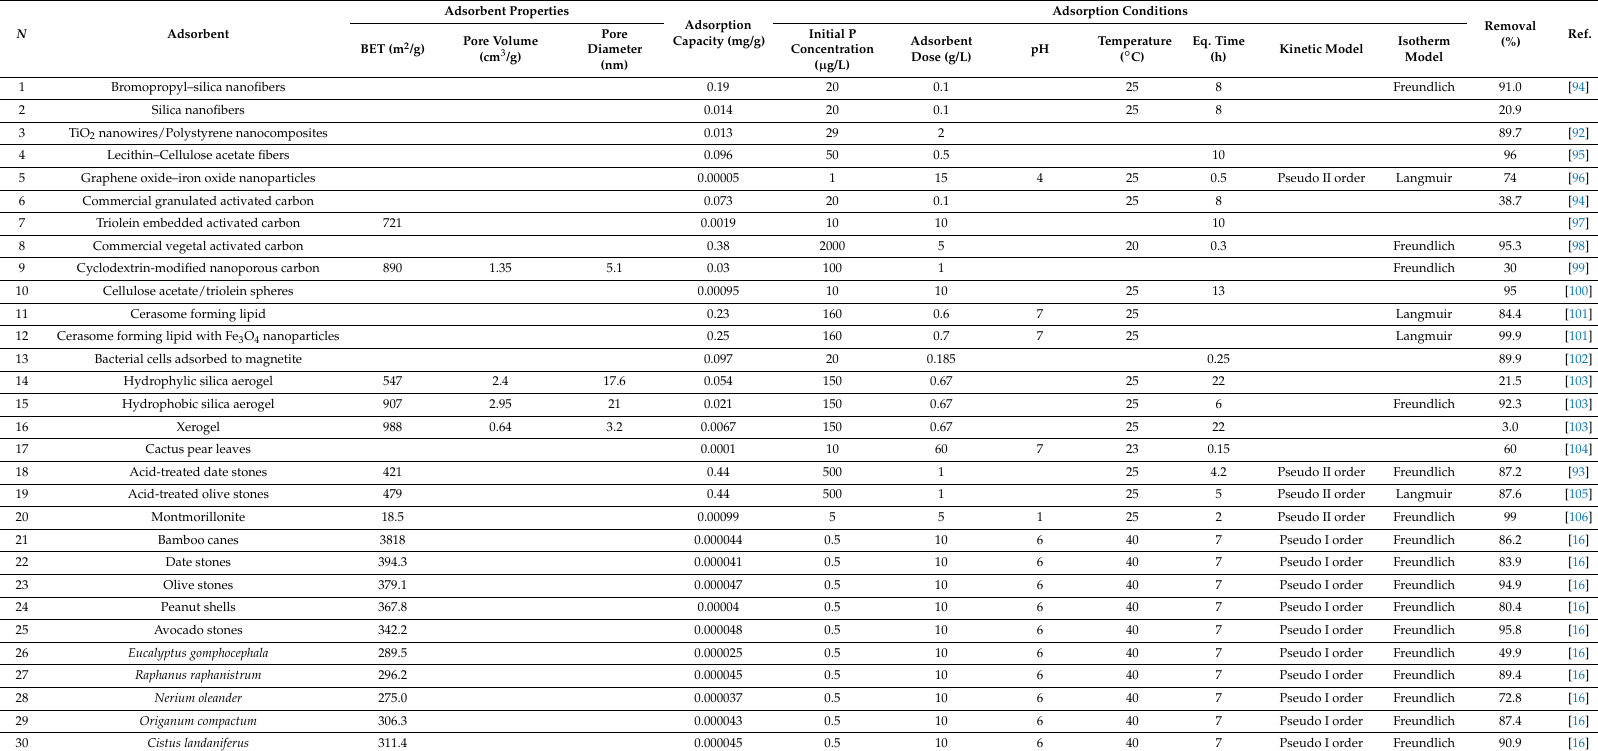
Table 12. Nanofibrous adsorbent properties and adsorption conditions for the removal of